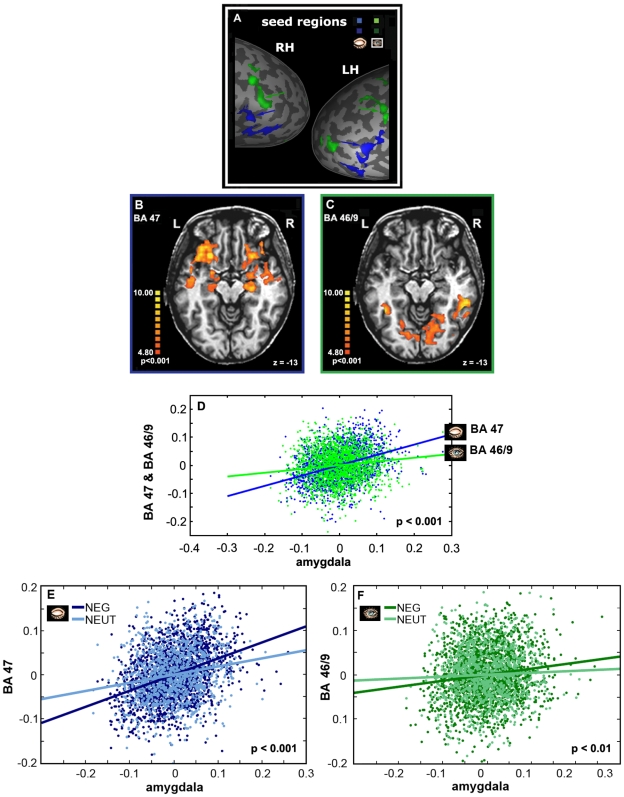
Correlation analysis for the PFC ROIs.(A) ‘Seed’ time courses defined separately for eyes open and closed are shown on the parts of unfolded hemispheres. ‘Seed’ time courses were used to compute a voxel-by-voxel fit for the (B) BA 47 and for the (C) BA 46/9. Note a strong connection of the amygdala to the BA 47. The color scale indicates significance level. R – right hemisphere, L – left hemisphere. (D) Correlated activity of the VPFC (BA 47) and amygdala in comparison to the correlated activity of the DLPFC (BA 46/9) and amygdala, corresponding to mental sets of eyes closed and open, respectively. Note a significant difference between correlation coefficients. (E–F) Co-activation analyses respectively to the emotional context in music. A statistical comparison between the co-activation in the negative and neutral conditions was performed for the BA47 (E) and BA 46/9 (F).